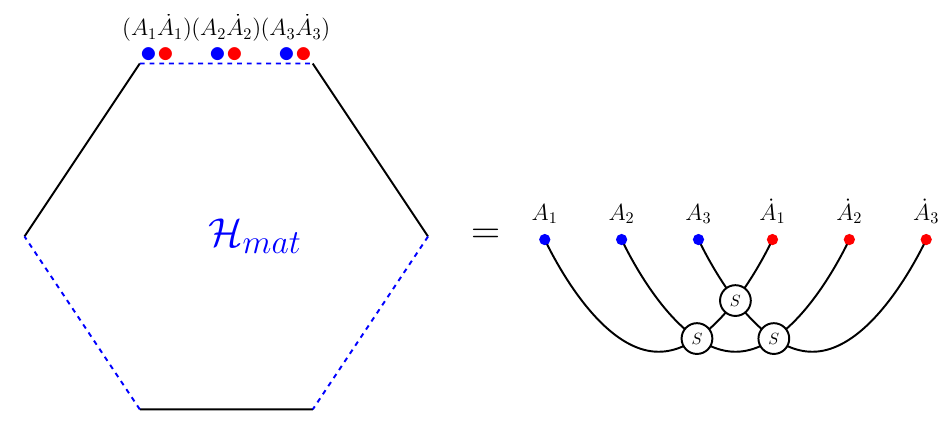
Figure 19 . The matrix part of the multi-particle hexagon form